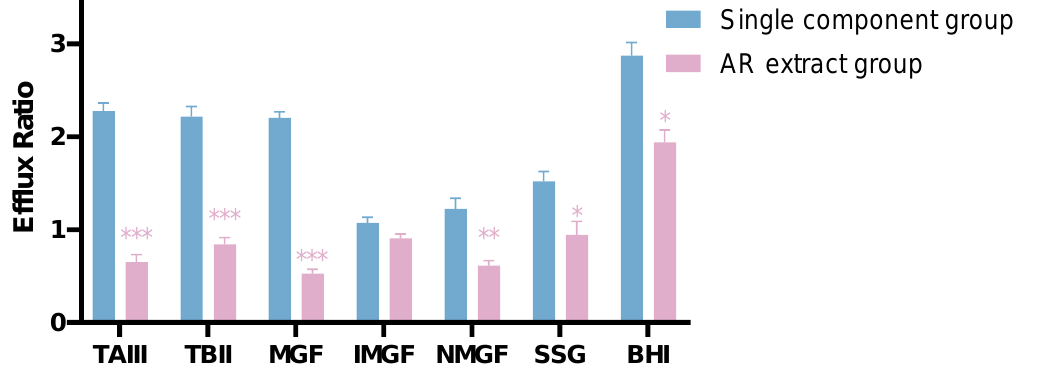
Figure 3. The efflux ratio of seven components in the administration of AR extract and monomers. Data are expressed as mean ± SD (n = 3). * p < 0.05, ** p < 0.01, *** p < 0.001 compared to Single component group.